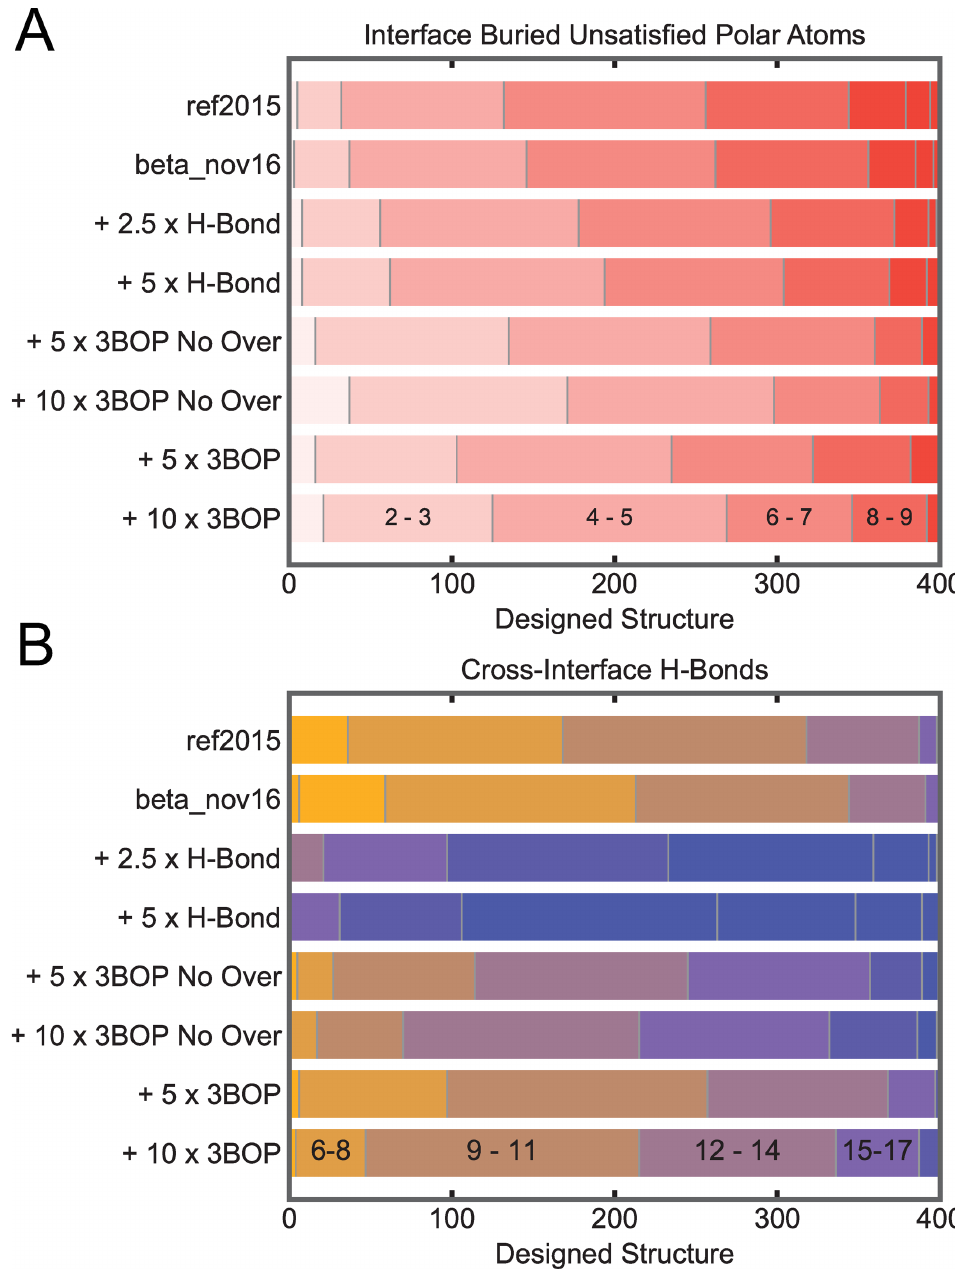
Fig 2. Effect of 3BOP on de novo interface design. 40 mini-proteins of mixed alpha/beta and all alpha topology were docked against barnase (PDB: 1BRS) using PatchDock[12,13] and the top 10 docks for each selected. Residues within 10 Å of the interface were allowed to repack on barnase and to design with all 20 amino acids on the mini-protein. A ramped-repulsive pack and minimize scheme was used to arrive at the final amino acid sequence[14] using the score function described at the left of the panels. All methods that start with “+” use ref2015. For “+ 5 x 3BOP No Over”, the parameters were β = 5, σ = -5, and ω = 0 and for “+ 5 x 3BOP”, the parameters were β = 5, σ = -5, and ω = 5 for all polar atoms. The “+ 10 x” variants used 10 instead of 5 for the respective parameters. As the maximum energy for an h-bond in Rosetta is approximately -2 kcal/mol, the “+ 2.5 x H-Bond” and “+ 5 x H-Bond” increased the maximum h-bond energy to -7 and -12 kcal/mol respectively. A) Number of buried unsatisfied polar atoms at the interface. In order from the left, vertical divisions indicate the number of proteins that have 0–1, 1–2, 2–3, or more unsatisfied polar atoms as indicated in the last row. B) Number of cross-interface h-bonds. In order from left, each division represents the number of proteins that had from X to (X+2) cross-interface h-bonds which each division to the right representing (X+3) to (X +5). See S1 Text for more information and S1 Scripts for scripts to reproduce the data in S1 Data.